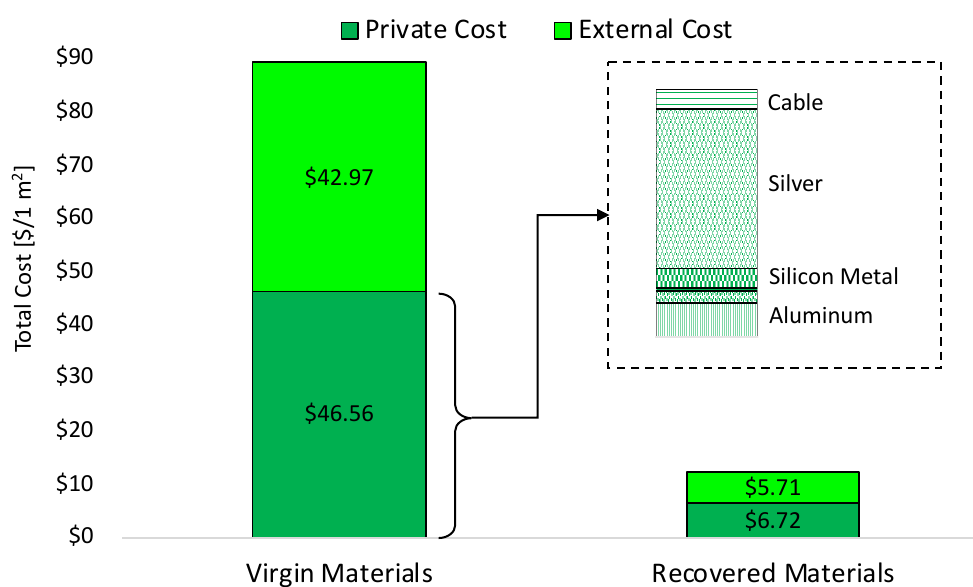
Figure 6. Virgin material vs. recovered material total cost. The virgin materials’ private and external cost data were pulled from our group’s earlier study [19], while the recovered materials’ data were pulled from the estimations made in this paper.